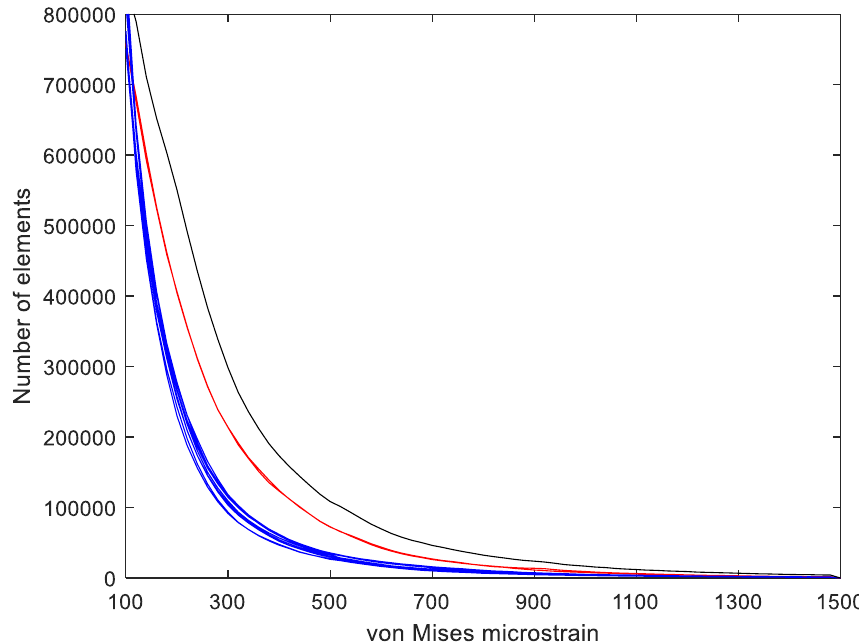
Figure 3. The number of elements that experienced a specific strain magnitude using a frequency bin size of 20 µε. The plot shows the strains from all 12 separate unilateral bites (2 incisor bites [red lines] and 10 molar bites [blue lines]) and the cumulative peak strains for all bites (black